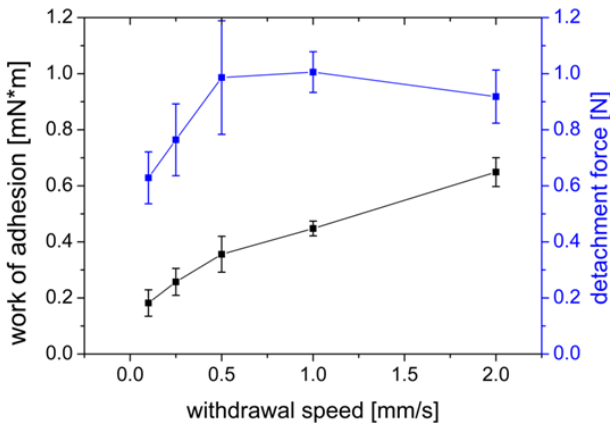
Figure 6. Influence of the withdrawal speed of a PVA film on the work of adhesion (mN × m) and detachment force (N) measured on a gel of 2% agar and 4% mucin. Mean ± SD, n = 6.